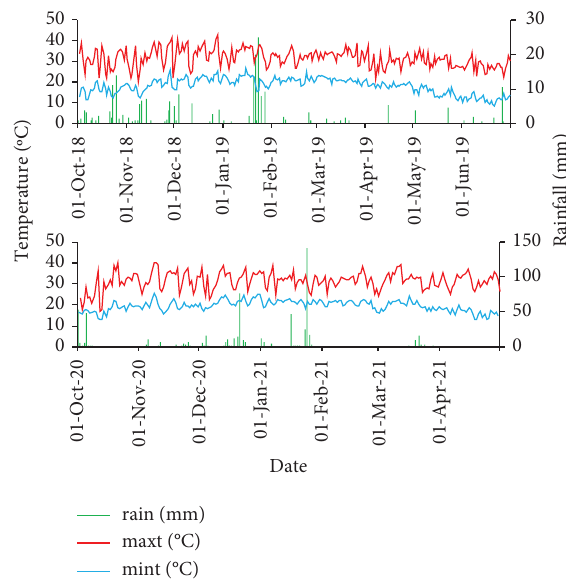
Figure 2: Rainfall, maximum and minimum temperature from Syferkuil during the 2018/19 and 2020/21 cropping seasons.